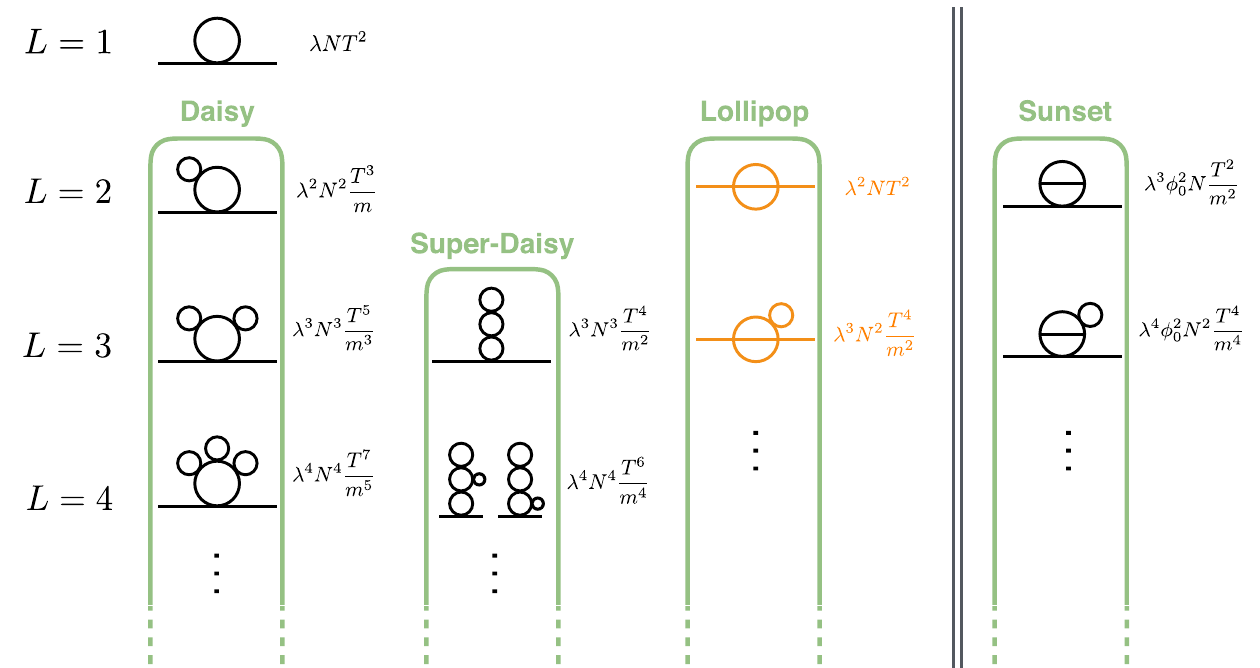
when (cid:7) φ (cid:8) = φ 0 > 0. We do not show contributions which trivially descend from e.g. loop-corrected quartic couplings. Lollipop diagrams (in orange) are not automatically included in the resummed one-loop